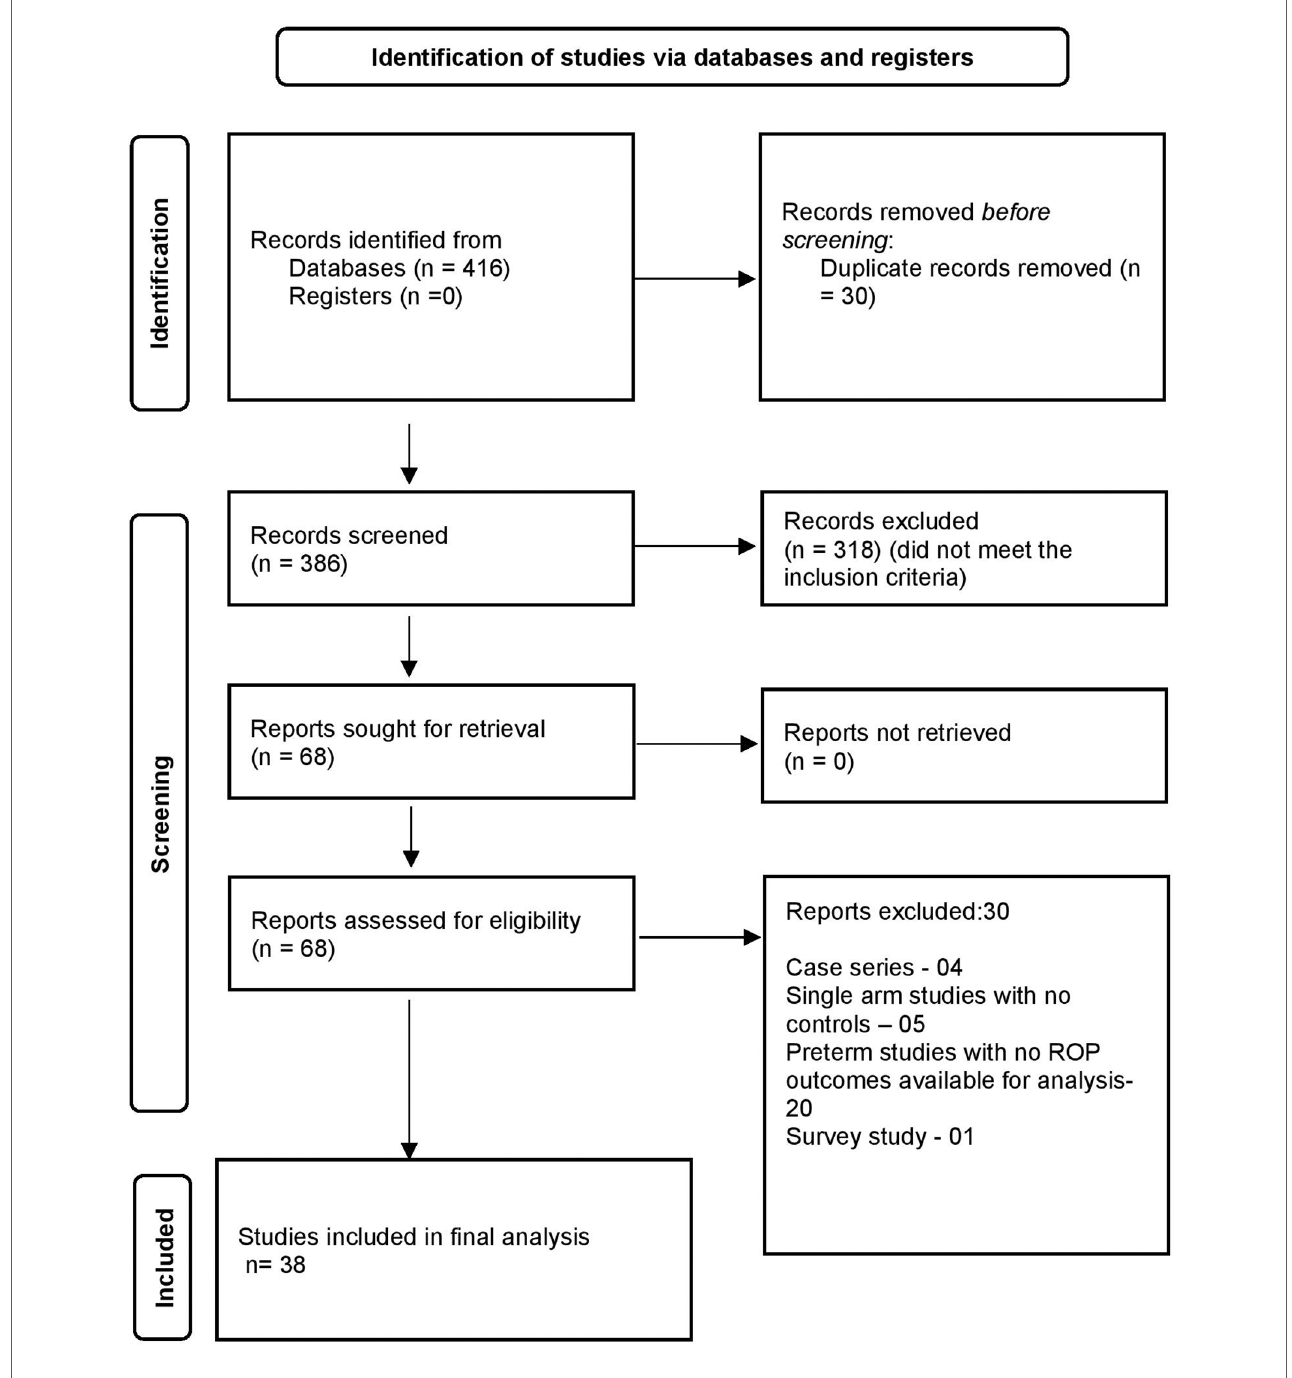
FIGURE 1 Flowchart of search results (adapted from PRISMA